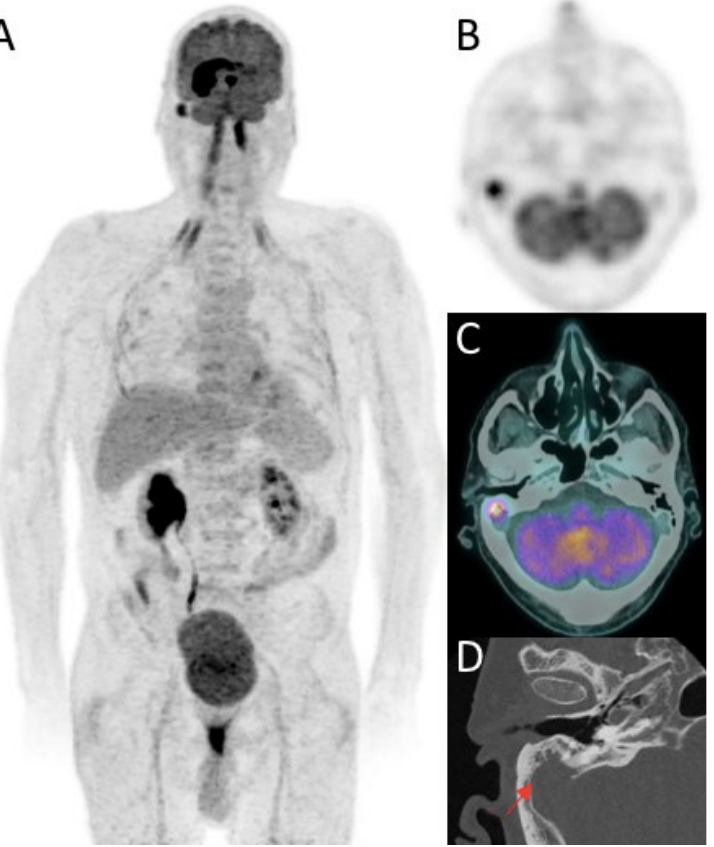
Figure 6. 18 F-FDG PET/CT reveals systemic involvement in the right mastoiditis in a patient with right temporal and paraventricular brain lesion highly avid for 18 F-FDG. A : Maximum intensity projection (MIP) of 18 F-FDG PET images. PET images showed an hypermetabolic right mastoid process filling: SUVmax at 8.8 ( B : axial PET images, C : axial PET/CT fusion). Imaging was completed by a dedicated thin-section CT scan which revealed irregular focal bone lysis of the right mastoid ( D ). Histological examination confirmed a B-cell lymphoma